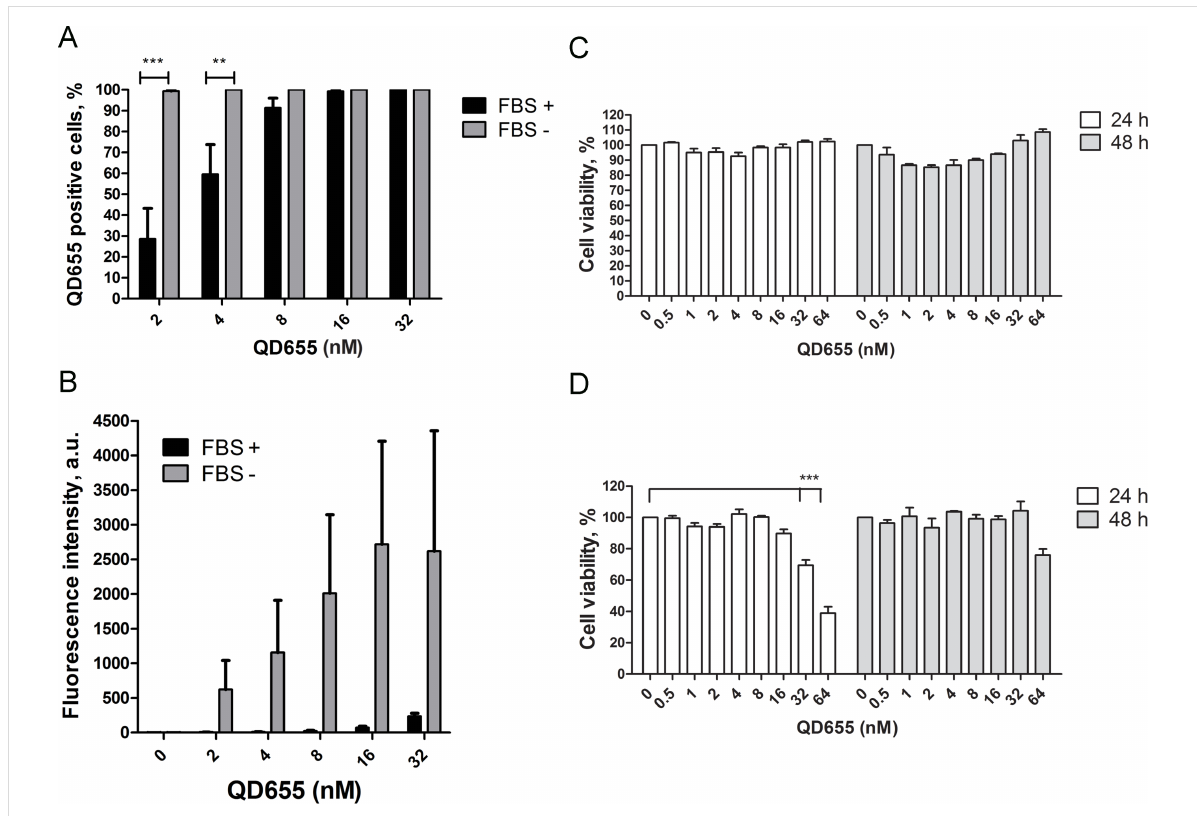
Figure 1: Characterisation of the optimal quantum dot (QD) incubation conditions in mesenchymal stem cells (MSCs). QD uptake after 6 h of incuba- tion in MSCs cultivated in complete or serum-free medium expressed as the percentage of QD-positive cells (A) and the QD accumulation intensity (B). The impact of QDs on MSC viability after labelling in complete (C) and serum-free (D) medium following incubation for 24 h and 48 h. ** p -value < 0.01, *** p -value < 0.001.